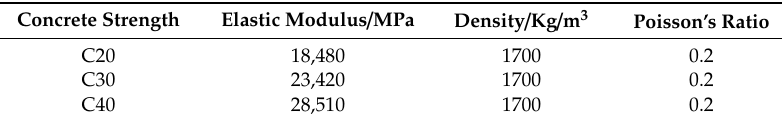
Table 8. Properties of